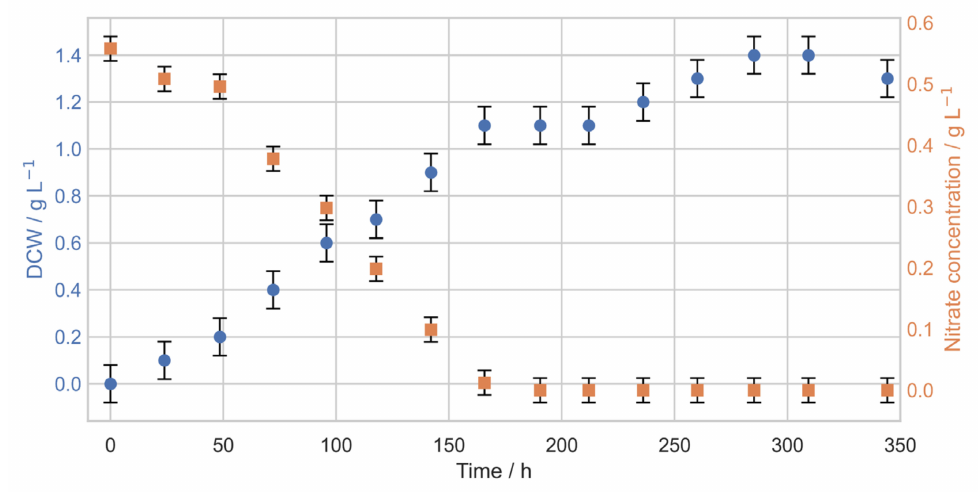
Figure 1. A photobioreactor cultivation of Synechocystis sp. PCC 6714 under nitrogen-limiting conditions showing the DCW (blue) and nitrate concentration (orange) during process. Error bars reflect the error of calibration